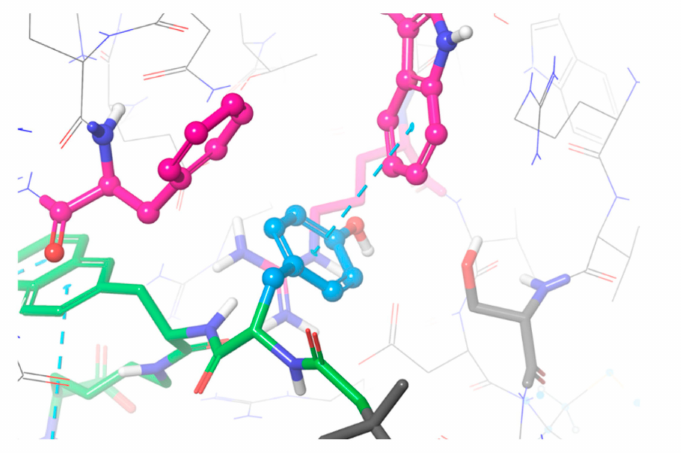
Figure 5. The suggested binding mode of compound BQ7859 depicted in green with the L-tyrosine substituent coloured in blue, interacting with amino acids Phe546, Trp541, and Arg463 within subpocket 2 depicted in